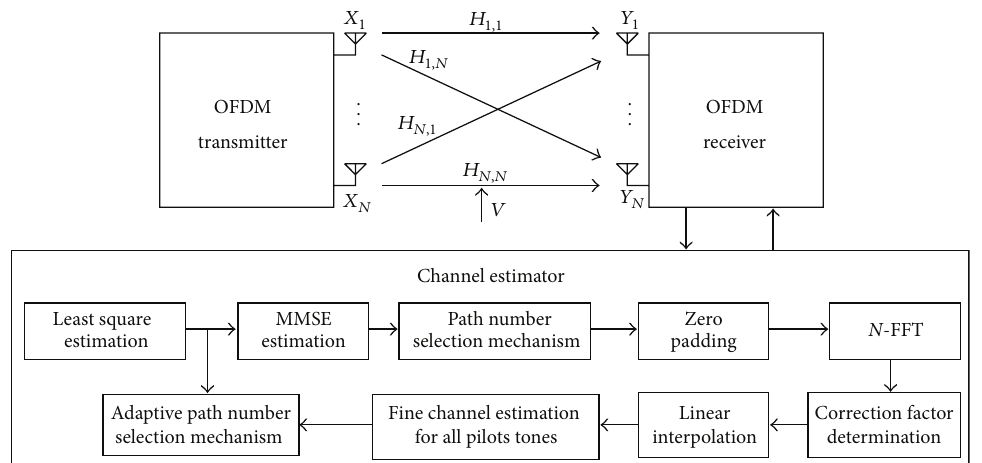
Figure 1: Block diagram of pilot tone channel estimation aided with adaptive path number selection mechanism for MIMO-OFDM fading